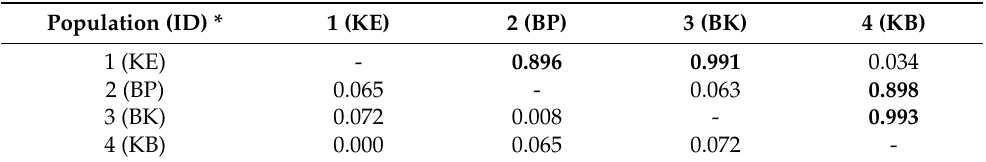
Table 4. Pairwise Tamura–Nei genetic distances (below the diagonal); Pairwise Fixation Index ( F ST ) and the probability (significant Chi-square test in bold value; p -value < 0.05) for population differentiation based on 110 permutations of the sequence dataset (above the diagonal) among four populations of Batagur affinis .